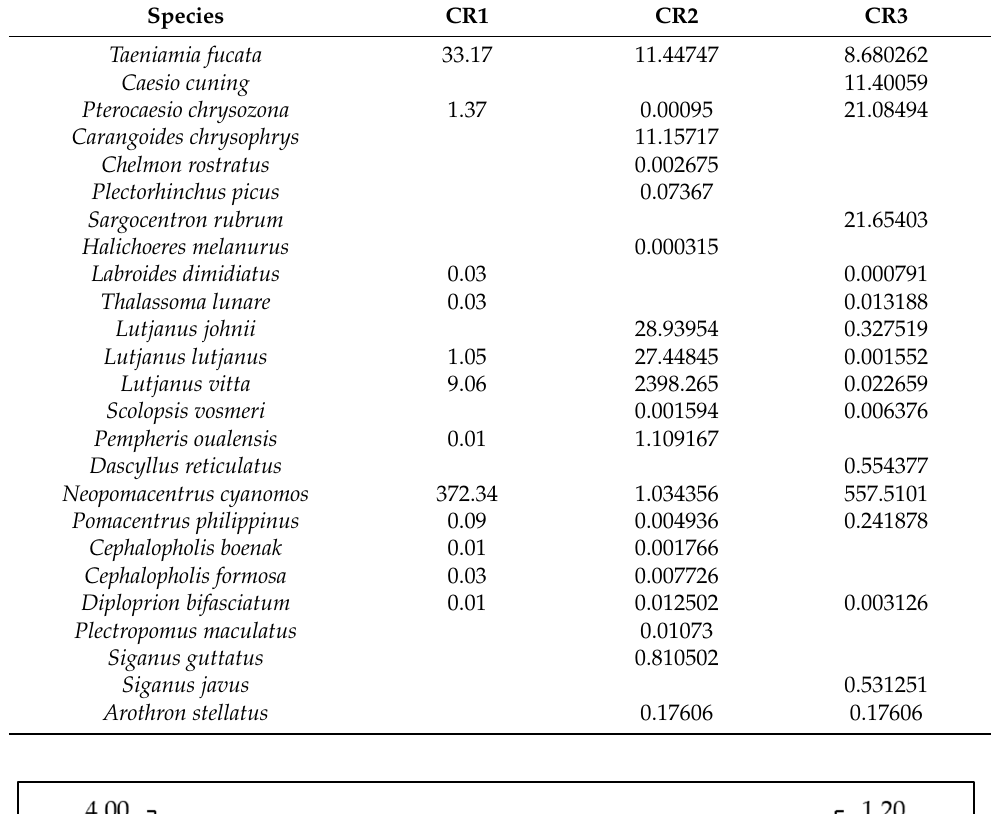
Table 4. Fish biomass of each species found in all three BK AR. Values are in kg m − 3 .